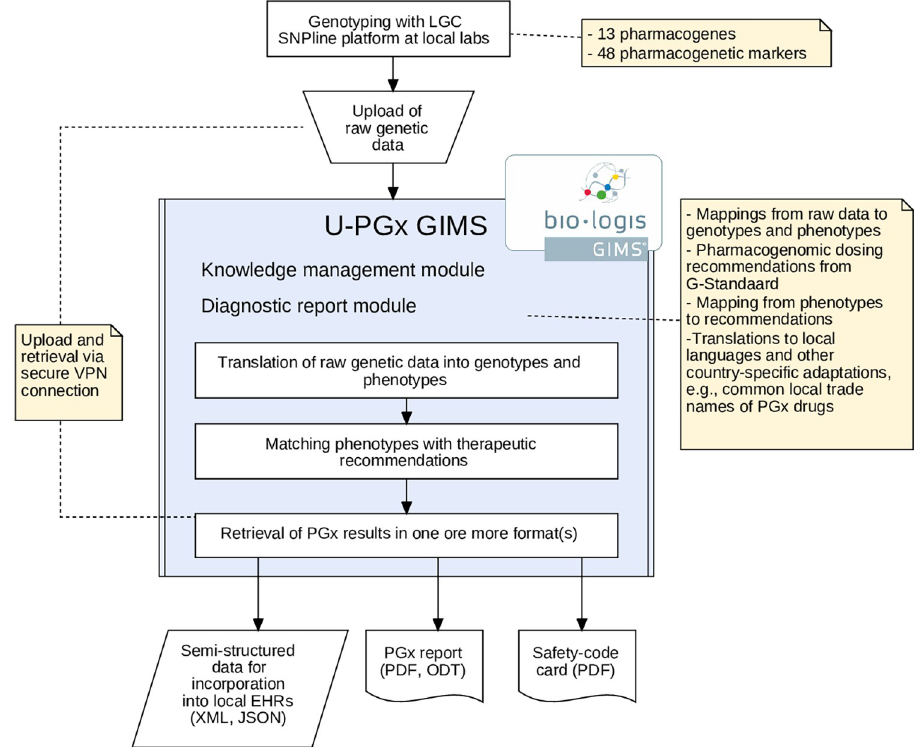
Fig 1. Framework of complementary decision support solutions implemented in the U-PGx project. The provided set of solutions accommodates the needs and requirements of the highly diverse implementation sides while guaranteeing a standardized intervention. Clinical sites with the infrastructural capabilities for interruptive CDS alerts in the form of pop-up messages in the EHR or e-prescription system are provided with semi-structured data. For all other sites, passive CDS can be delivered either inside the EHR system as a digital report, or outside the EHR system via mobile- and paper-based solutions. A more detailed technical description is available in [14].